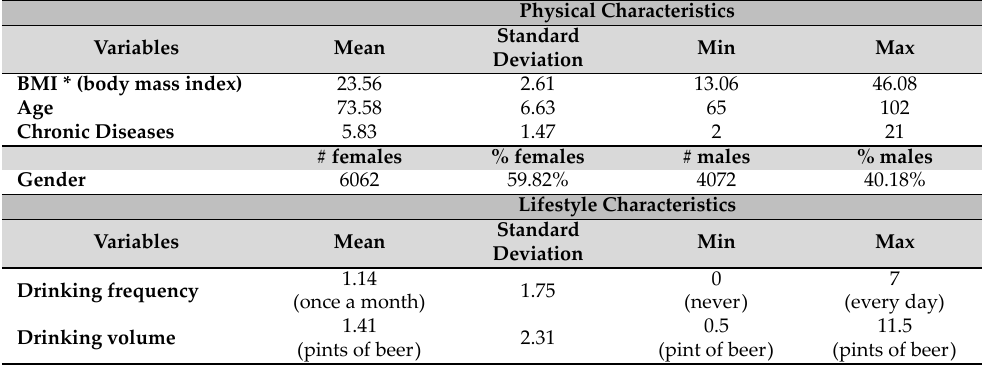
Table 6. Summary Statistics of the Determinants of Healthy and Active